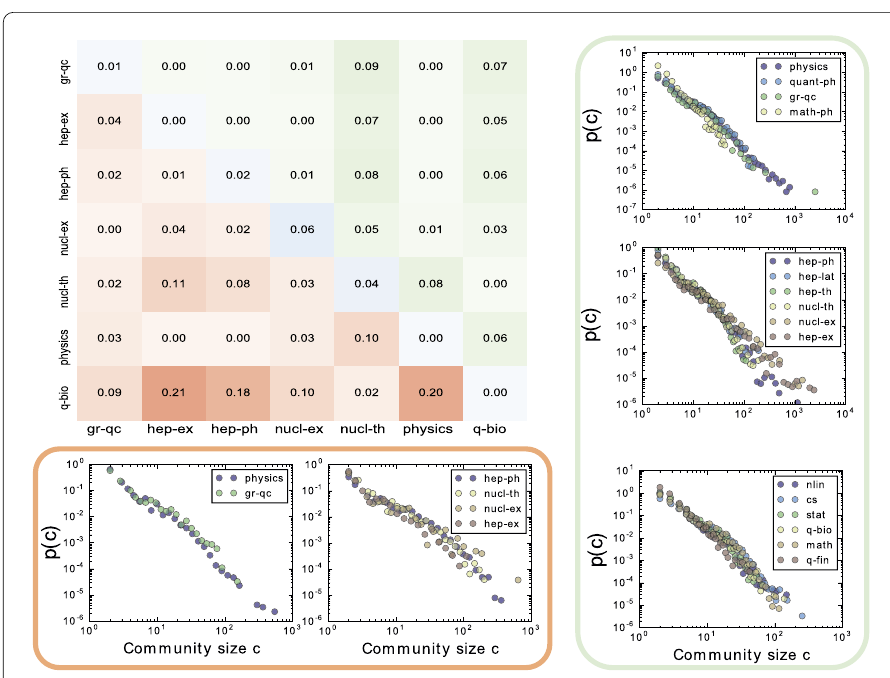
Figure 7 Distribution of community sizes. In the green box, we plot the community size distributions obtained from the underlying graph of the original simplicial complex. In the red box, we plot the community size distributions for the categories for which we performed the simplicial reduction. The central matrix shows: the JSD between the community size distributions of the original categories (green cells, upper triangular matrix), the JSD between the community size distributions for the transformed complexes (red cells, lower triangular matrix), and the JSD between the size community size distributions of the categories before and after the reduction. In all cases we find that the differences between the various distributions are small (JSD is defined in